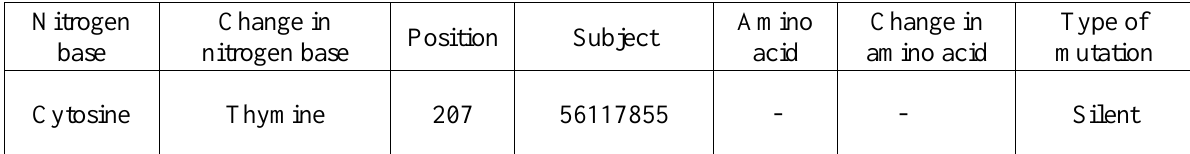
Table (4): Changes in Nitrogenous Bases and Their Effect on Translating Amino Acid of The QacE gene for Ps- 5 Isolate of P.